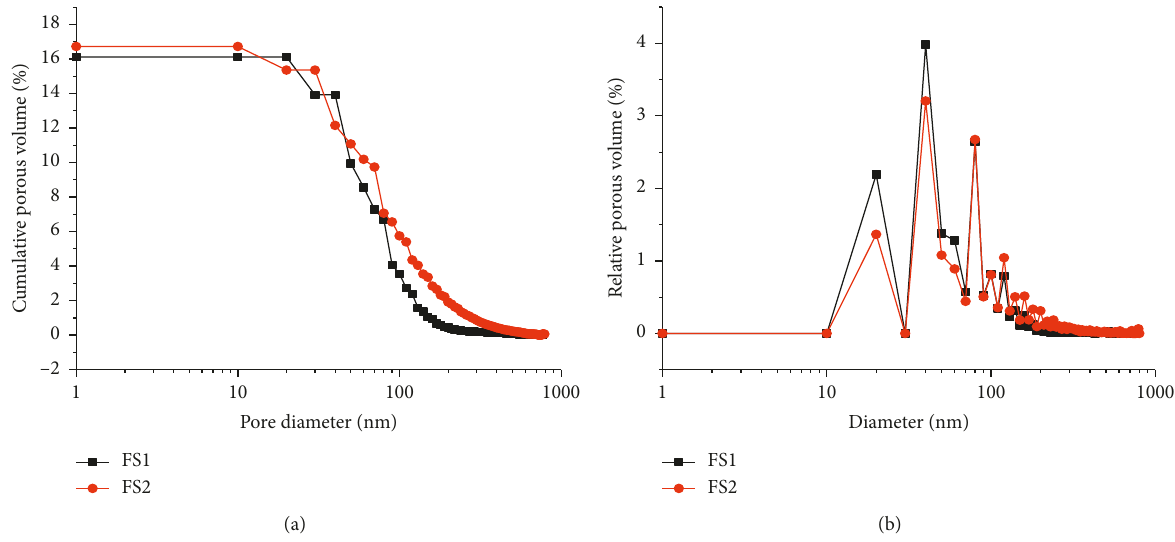
Figure 11: Pore size distribution of hardened cement paste by FIB/SEM: (a) cumulative curve; (b) relative curve.